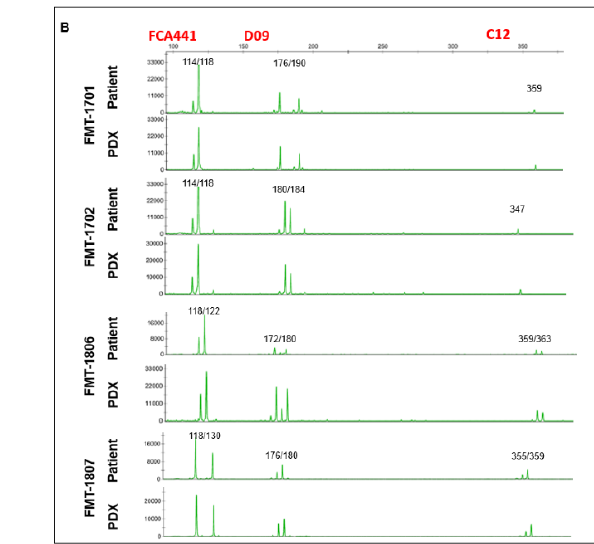
Figure 2. Tumor growth is represented as tumor volume versus time. Six mice were included per group.